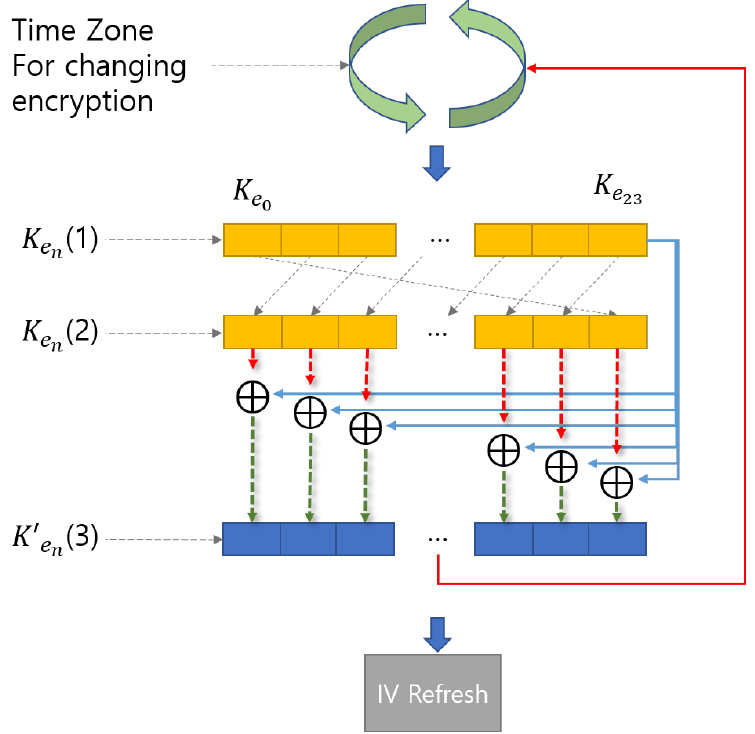
Figure 8. Process through which the cipher keys are changed. In Figure 8, the process of changing the ciphertext is as